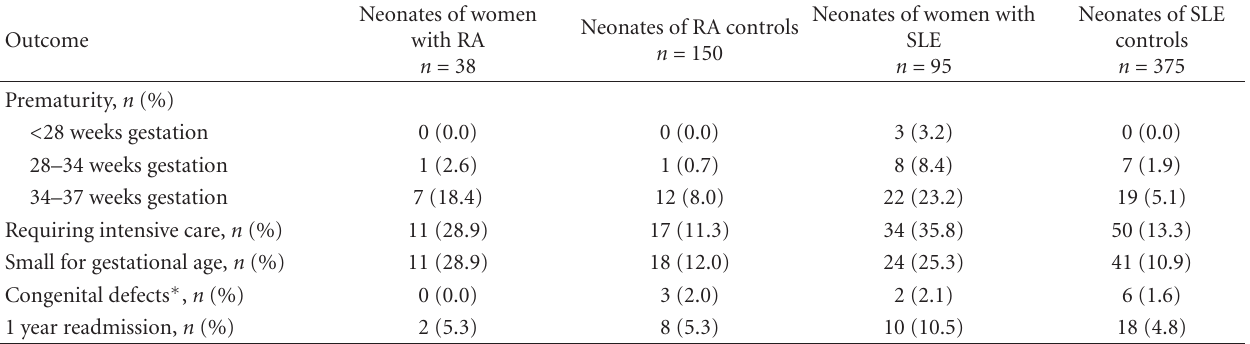
Table 2: Summary of neonatal